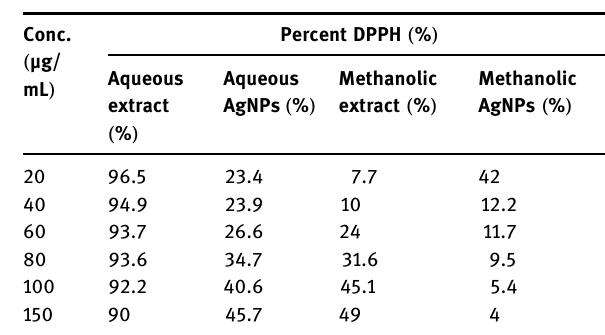
Figure 7: FTIR spectrum crude water extract of Tropaeolum majus .